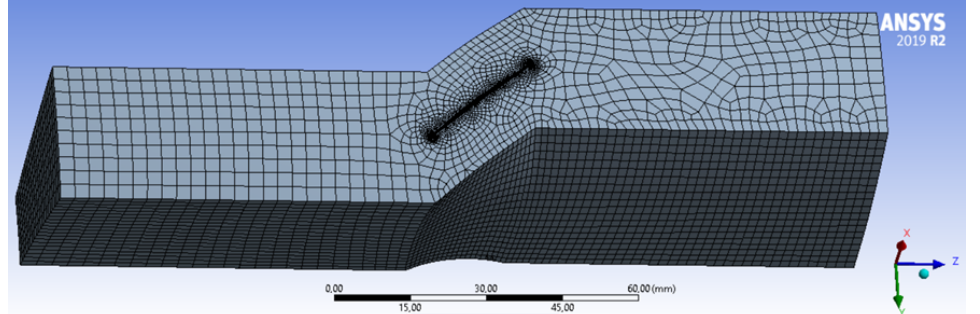
Figure 3. Discrete fluid domain mesh.